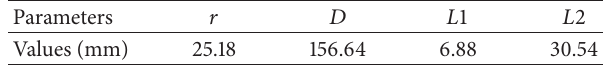
Figure 8: Return loss 𝑆11 of the 3D spherical antenna (Table 3). Table 3: New dimensions of the 3D spherical antenna (Figure